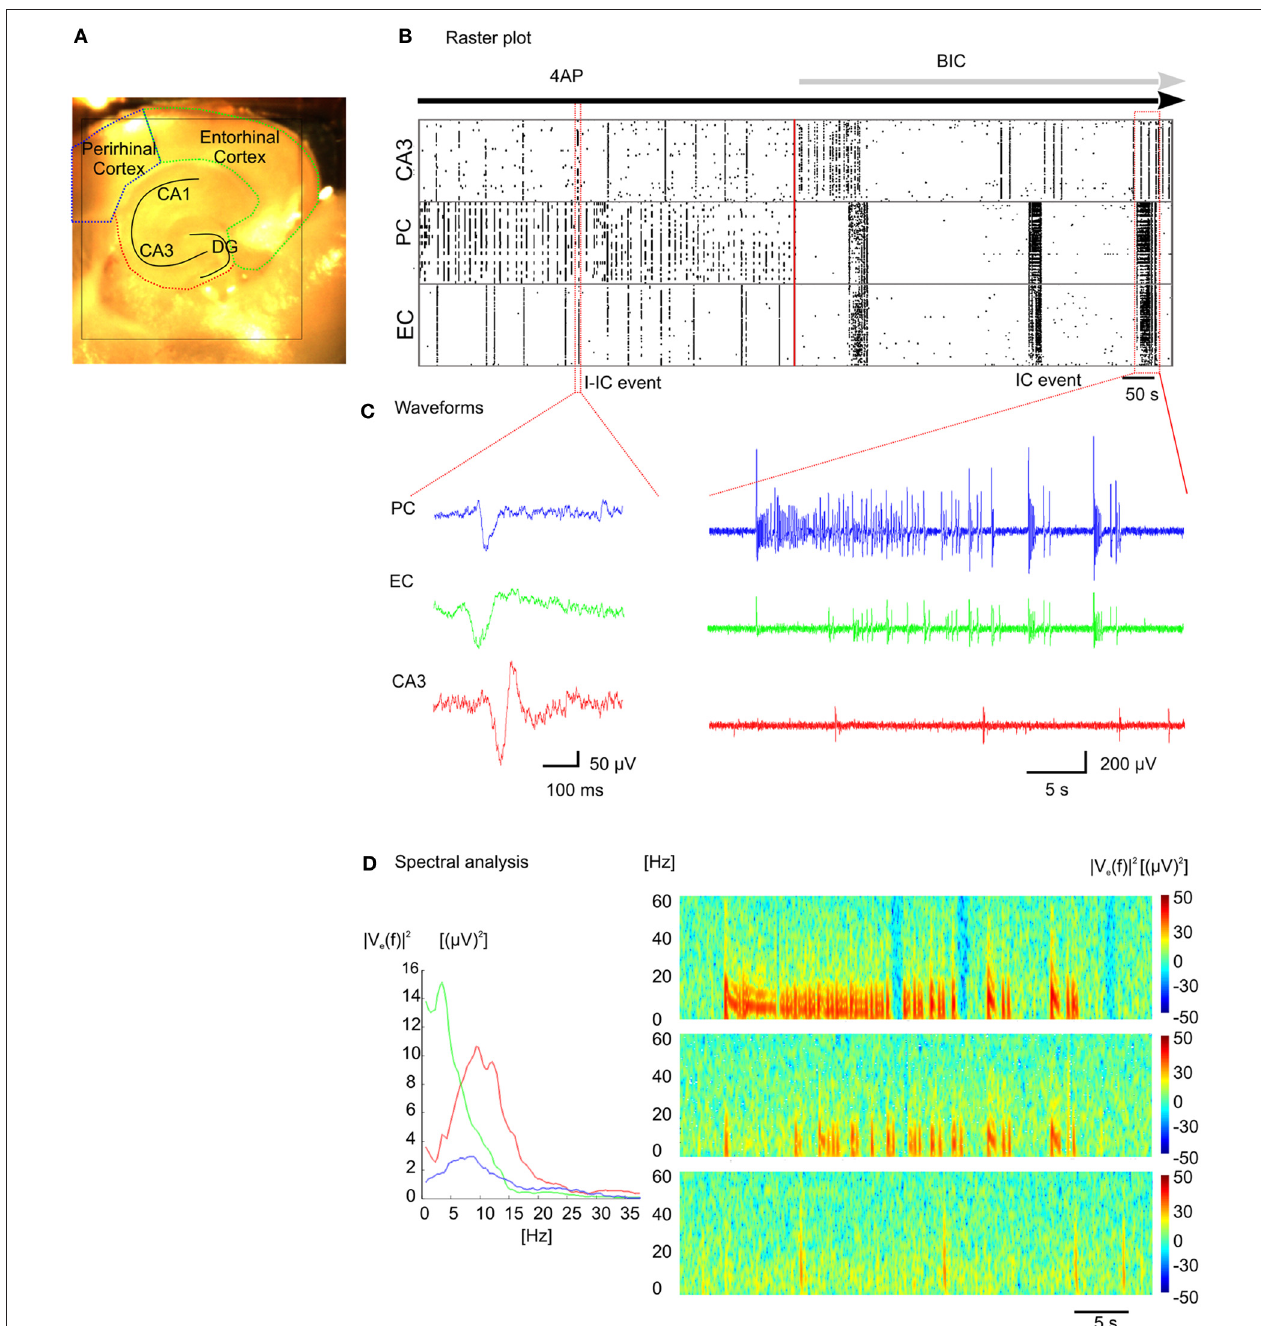
FIGURE 5 | Recording of epileptic like events. (A) Cortico-hippocampal slice over the active chip area (black square). (B) Raster plot representation of epileptic-like events induced in cortico-hippocampal slice by perfusion with 4-AP ([100 μ M]) or 4-AP + BIC ([30 μ M]). (C) I-IC events in the perirhinal